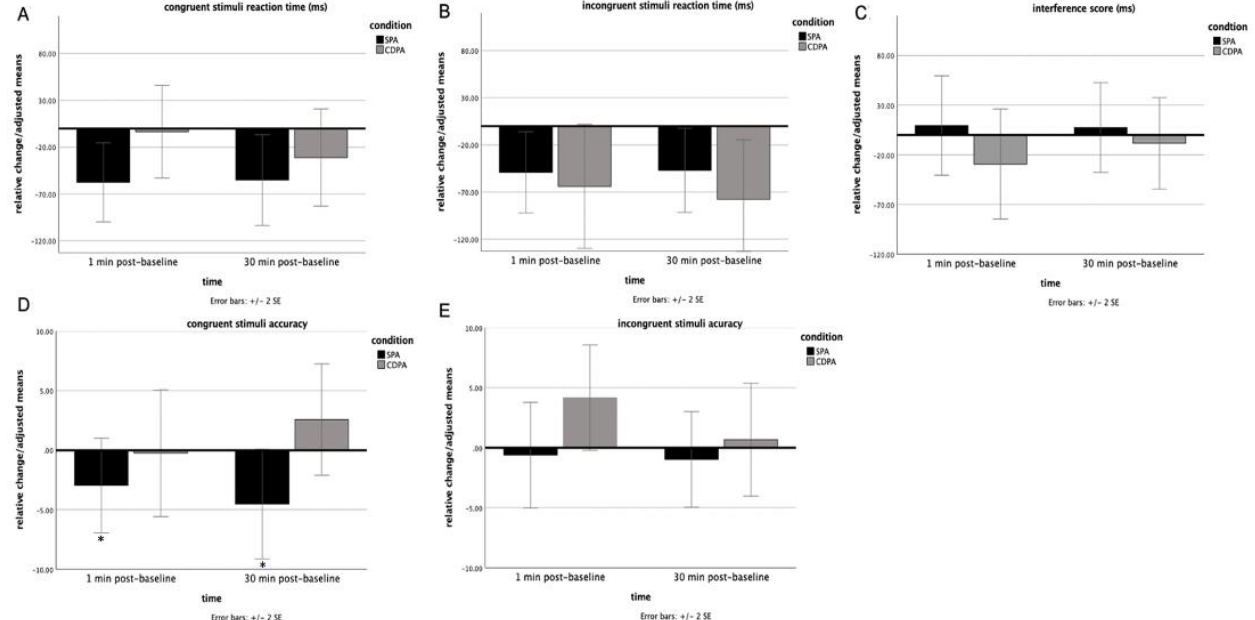
Figure 4. Effects of SPA and CDPA on ( A ) congruent reaction time, ( B ) incongruent reaction time,